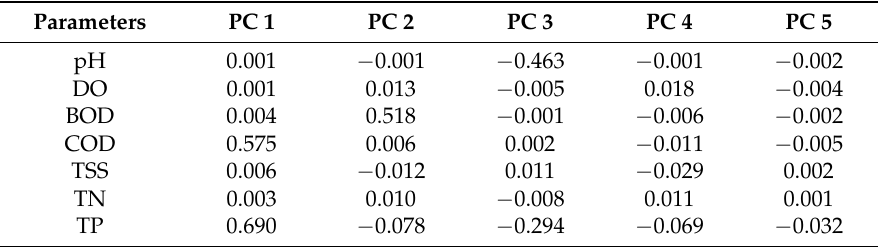
Table 8. Loading values, eigenvalues and variances of factors obtained from PCA in Gap